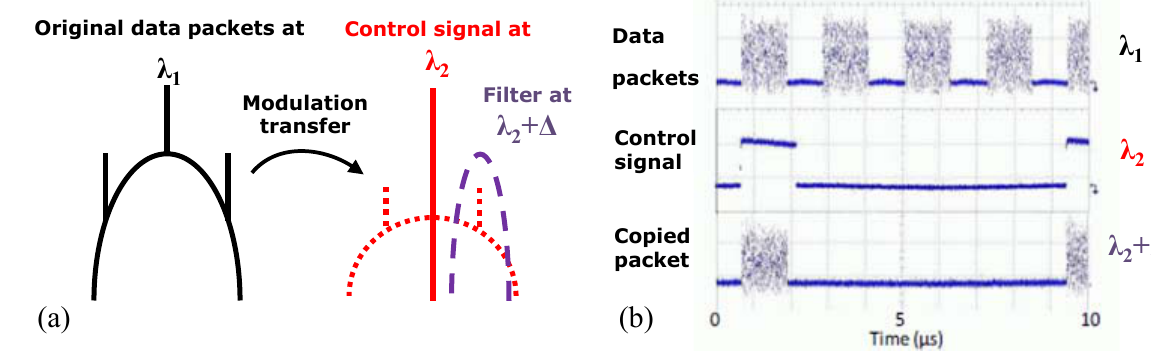
Figure 3. ( a ) Operating principle of packet switching by wavelength conversion and offset filtering; ( b ) Results of packet switching implementation in an 8 mm long Si